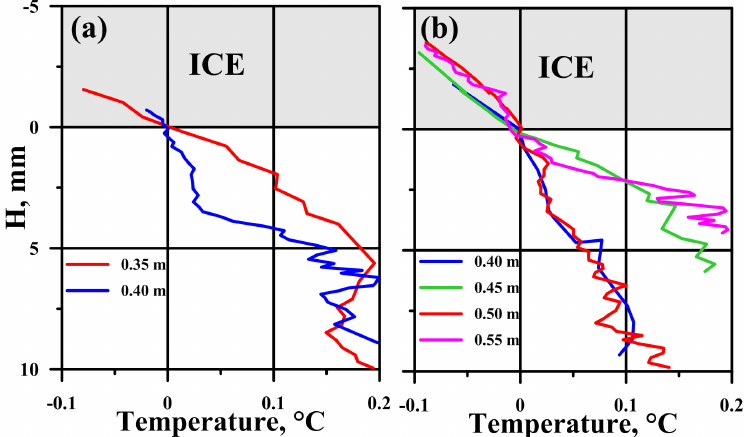
Figure 11. Fine-scale temperature profiles at Station 1 ( a ) and Station 2 ( b ) obtained during the freezing of miniature analog sensors in the ice with the one-hour averaging. H—distance from the ice–water interface.